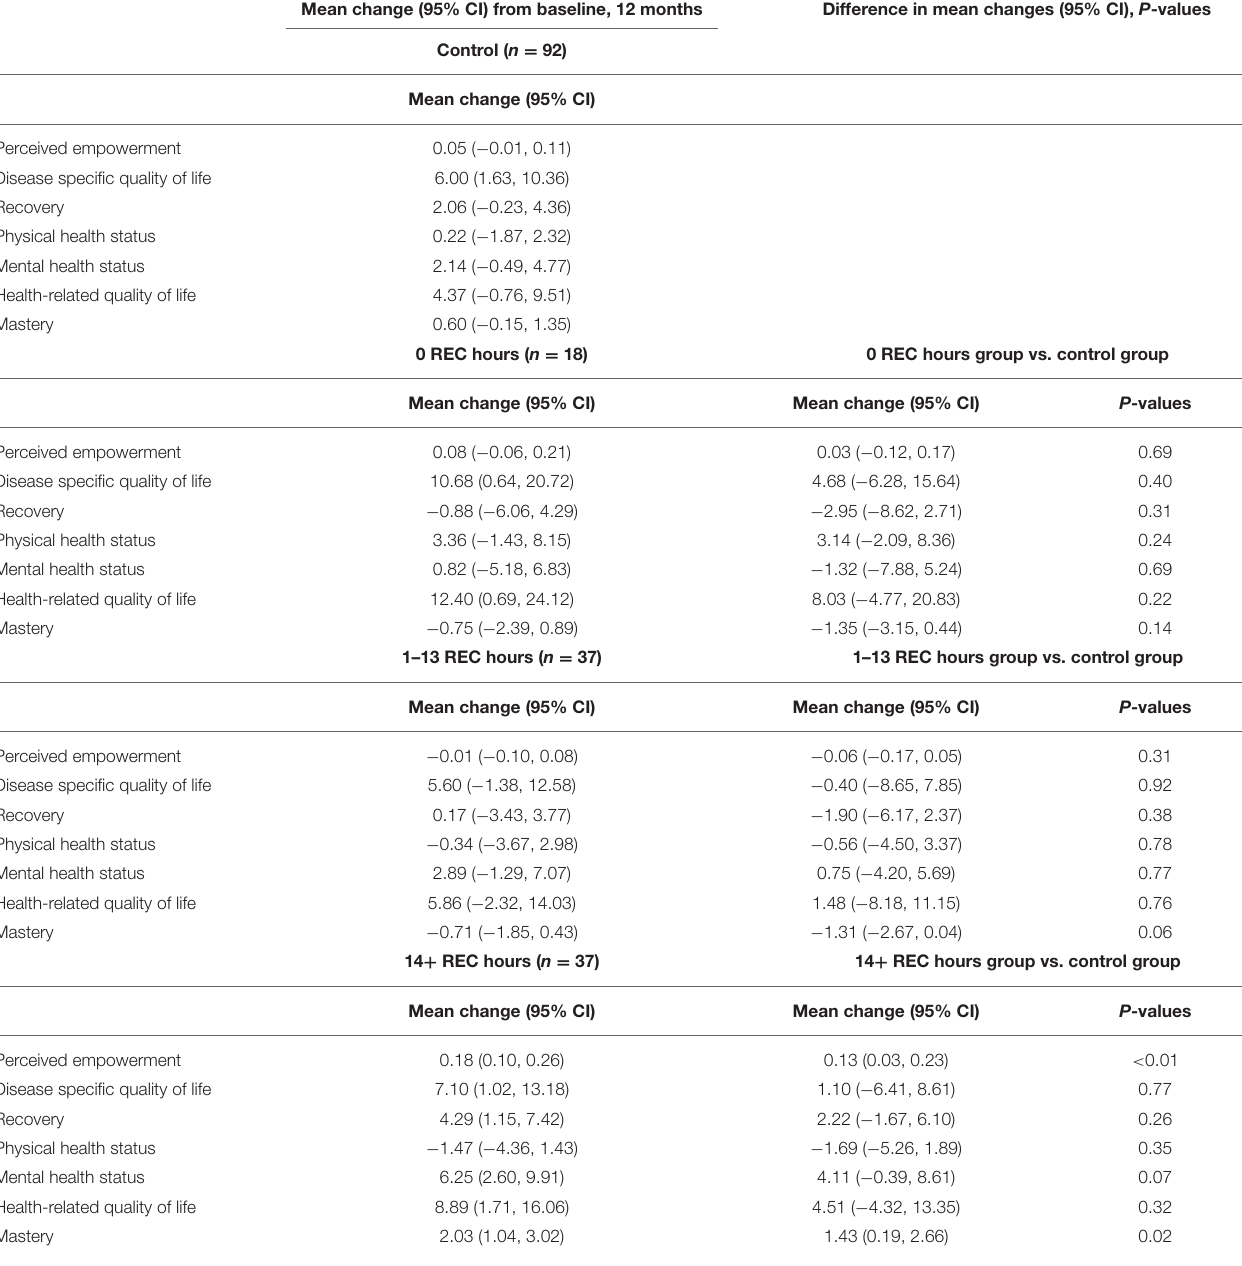
TABLE 4 | Model-estimated mean changes and 95% CIs, and difference in mean changes, 95% CIs and p -values from baseline to 12 months follow up for individuals with 0, 1–13, and 14 + REC participation hours vs. the control group ( post-hoc